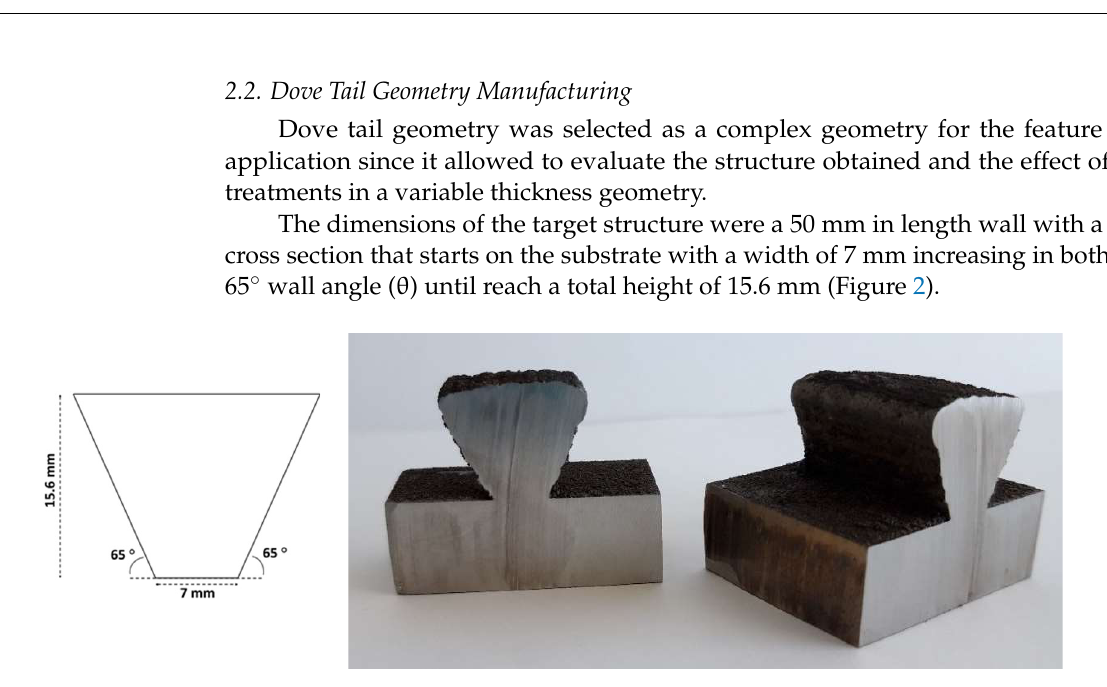
Figure 1. IBARMIA ZVH45/1600 Add+Process hybrid machine.